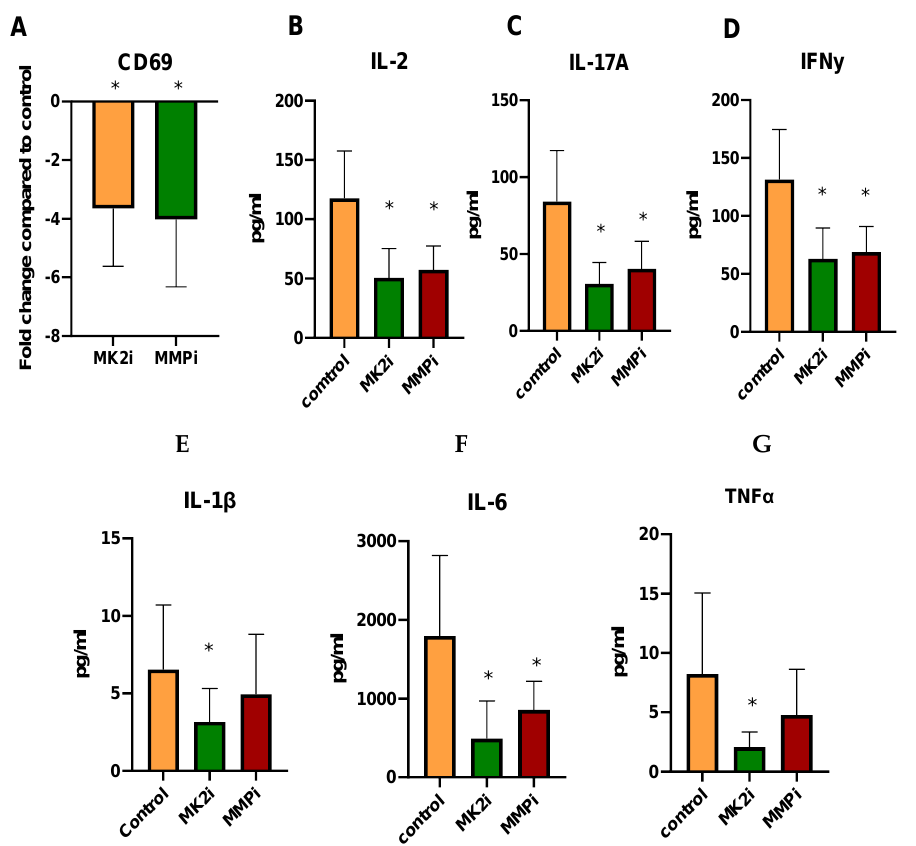
Figure 7. T cell activation markers are increased in active CD tissues but decreased when incubated with MK2i and MMPi where ( A ) CD69 gene expression is decreased in samples incubated with MK2i and MMPi compared to vehicle control and ( B ) IL-2, ( C ) IL-17A, ( D ) IFN γ , ( E ) IL-1 β , ( F ) IL-6, and ( G ) TNF α are decreased in tissue supernatants incubated with inhibitors. N = 8, * p < 0.05.